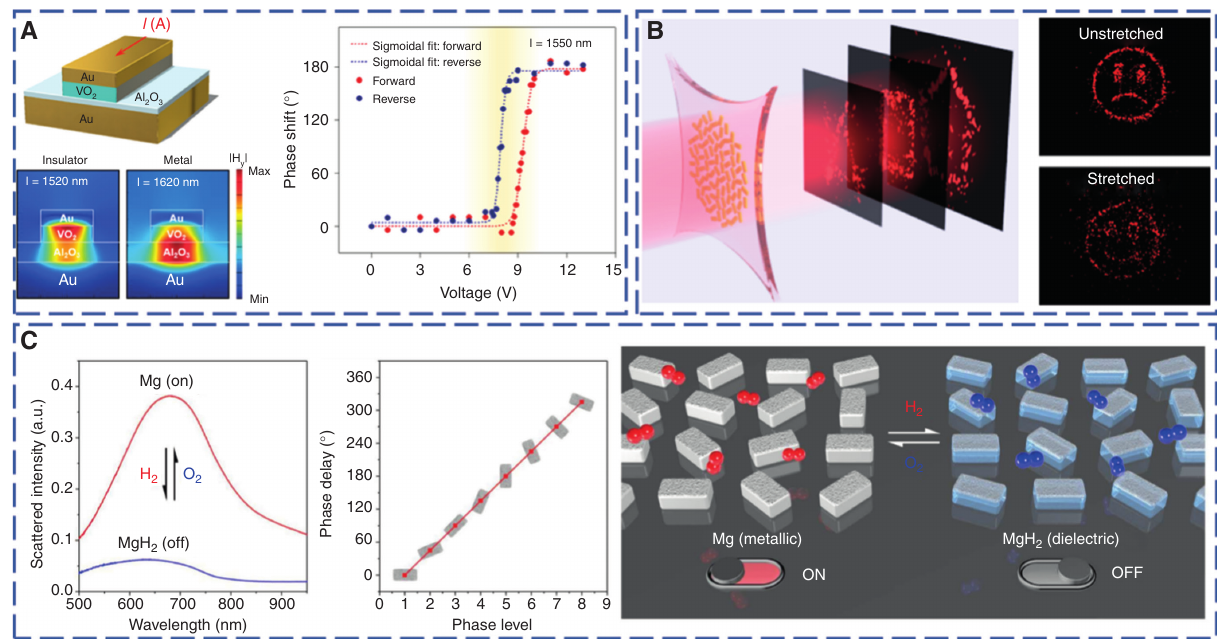
Figure 21: Dynamic metasurfaces using (A) phase-changed materials [152], (B) stretchable flexible substrates [153], and (C) reconfigurable chemical methods